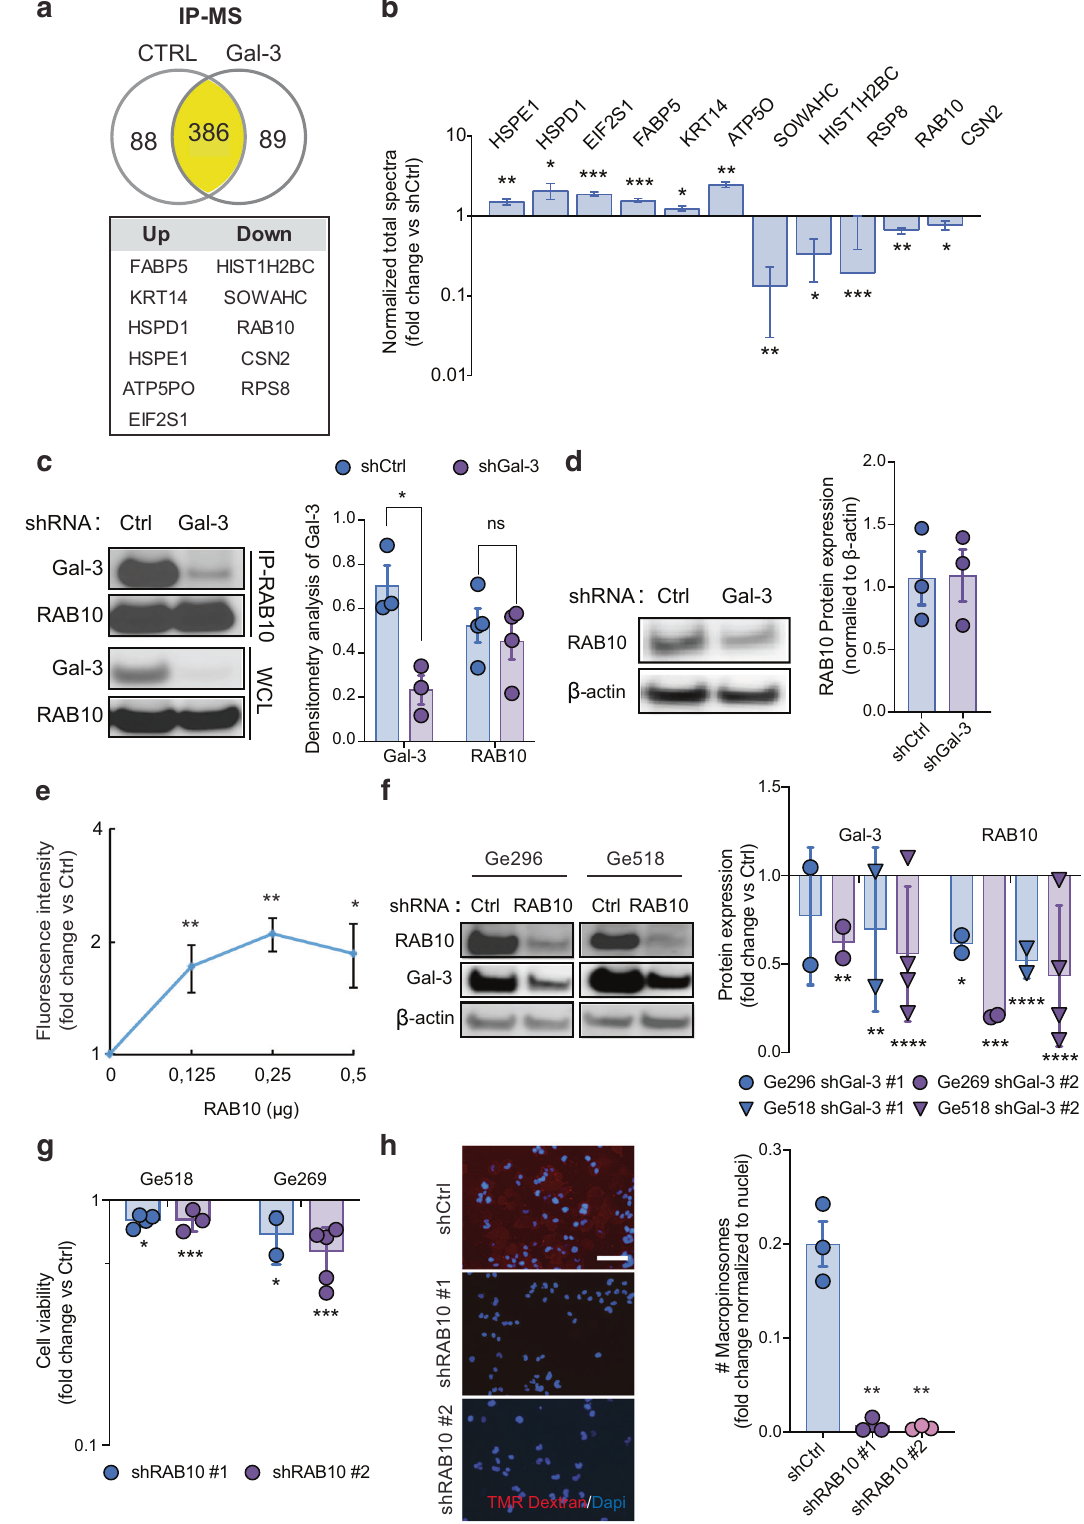
associated with Gal-3 (Fig. 5B). Moreover, in shGal-3 GSC, the enrichment analysis revealed the expression of proteins involved in stress response, heat shock protein family, and mitochondrion. In contrast, in shCtrl, we found enrichment for proteins involved in cell adhesion, actin-binding, myosin complex, and translational initia- tion (Supplementary Fig.